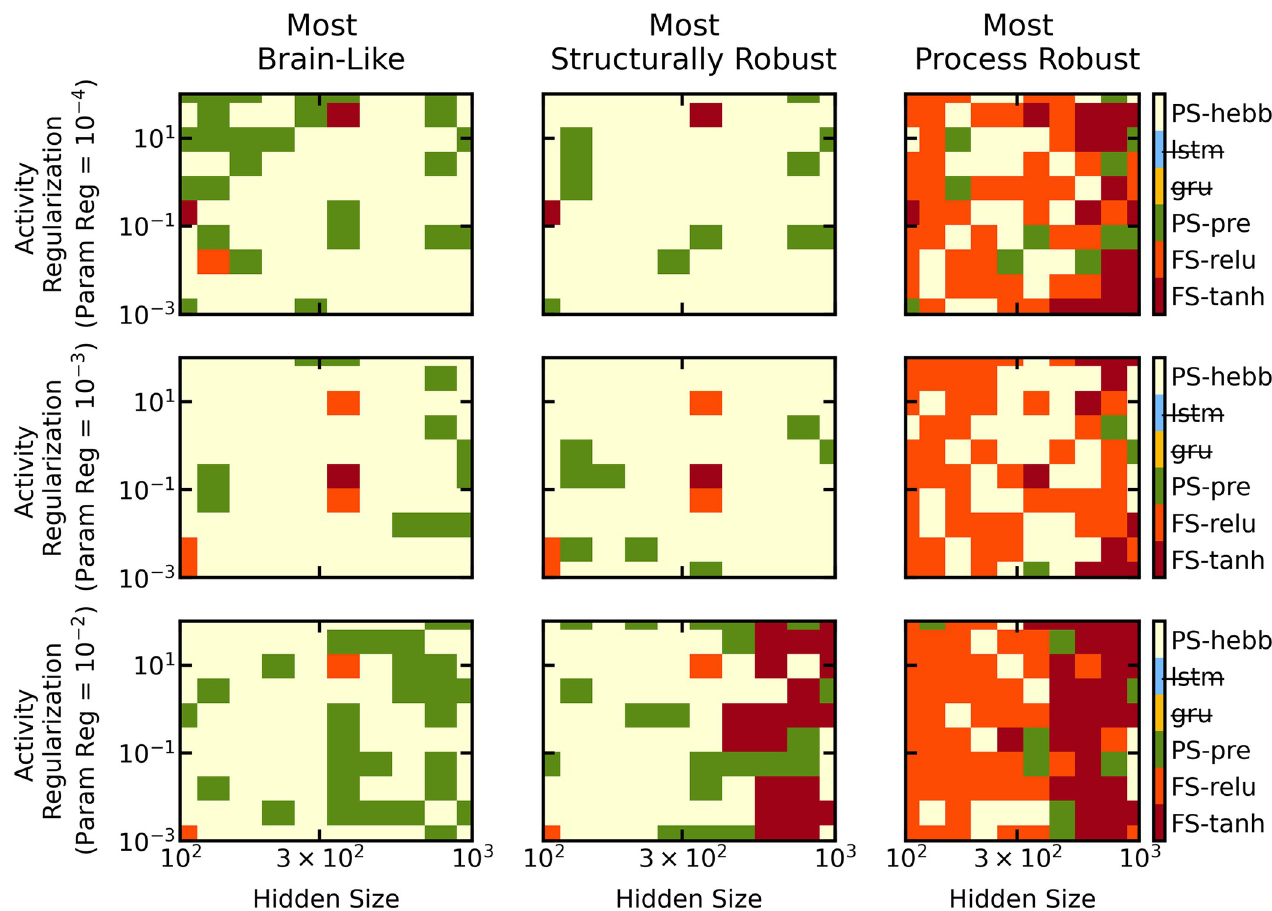
Fig 5. Results of the hyperparameter sweep across number of hidden neurons, parameter regularization strength, and activity regularization strength. Each row corresponds to a different parameter regularization (1e-4,1e-3,1e-2). Each column corresponds to a different observed quantity (brain-likeness, structural robustness, process robustness). Each subplot is a 10x10 grid, corresponding to 10 possible hidden size / activity regularization configurations. Shown in each square of that grid is the most brain-like/robust network corresponding to that particular hyperparameter configuration. LSTM and GRU networks were excluded (see S8 Fig for corresponding figure when they are included). Each color corresponds to a different network.